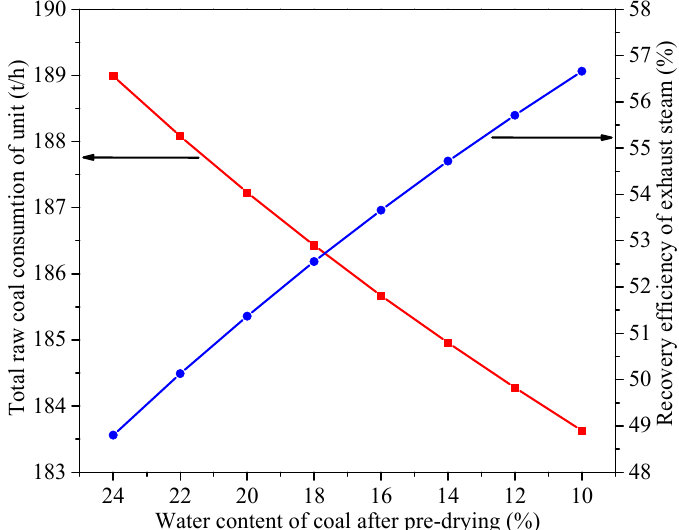
Figure 5. Impact of the moisture content in the dried coal on the performance of the proposed design.